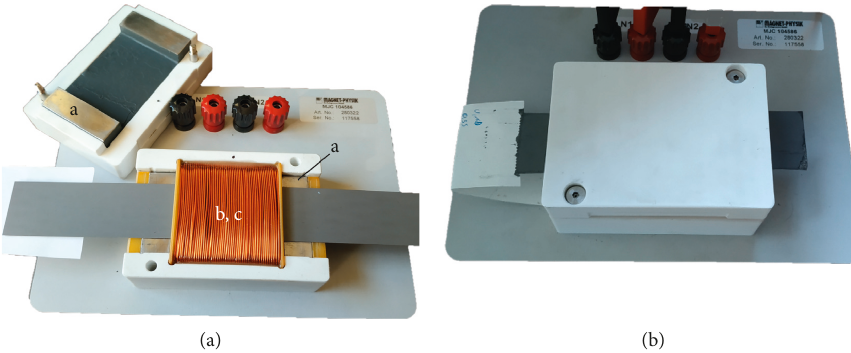
Figure 4: Connection for the measurement setup without cover and with cover where a represents yokes and b and c denote primary and secondary